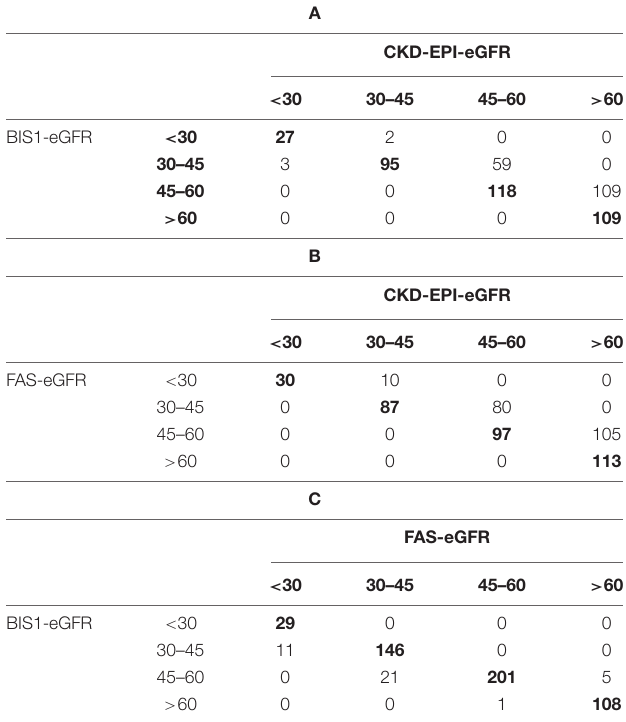
TABLE 3 | Confusion matrices of NH residents classified by either BIS1 or FAS compared with CKD-EPI